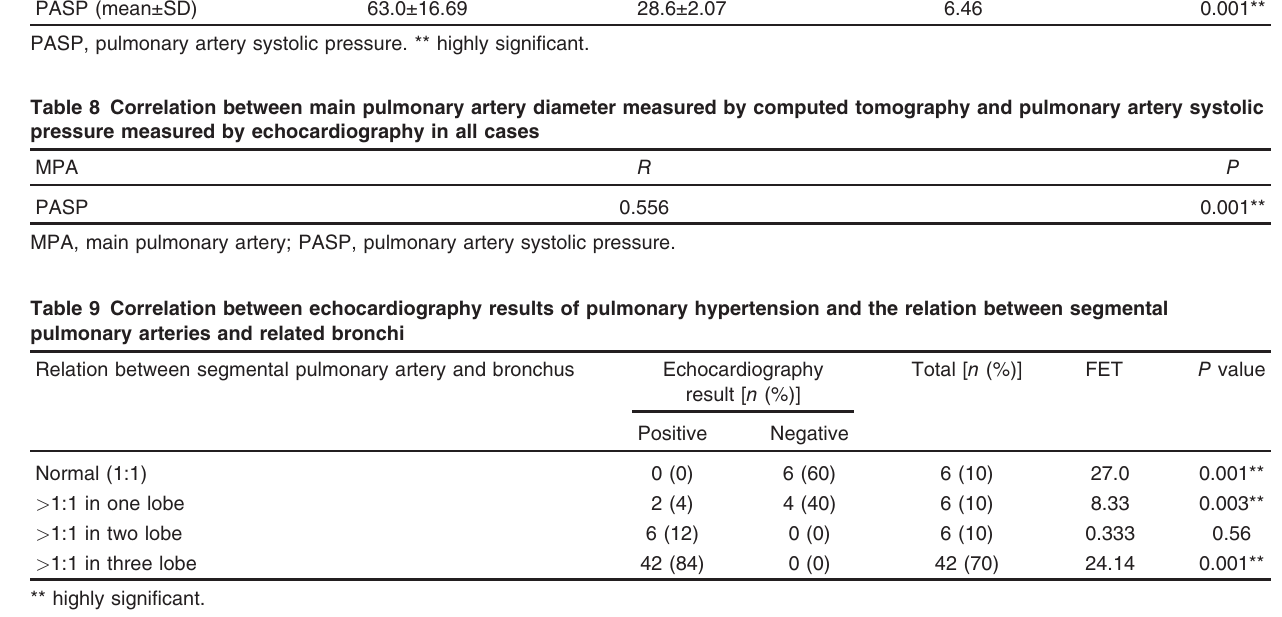
Table 10 Correlation between echocardiography results of pulmonary hypertension and the relation between main pulmonary artery diameter and aorta Relation between MPA and aorta Echocardiography result [ n